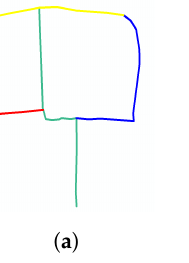
Figure 15. Road scene from the sketch (left), and two road scenes from OSM (middle and right). The topological relationship between the roads with TRMP in Figure 15a is the same as that in Figure 15b and different from that in Figure 15c. ( a ) Road scene from a sketch. The green road has matching priority. The topological relationship between the yellow and blue roads is that of touching . ( b ) Candidate road scene from OSM. The topological relationship between the yellow and blue roads is that of touching . ( c ) Another candidate road scene from OSM. The topological relationship between the yellow and blue roads is disjoint